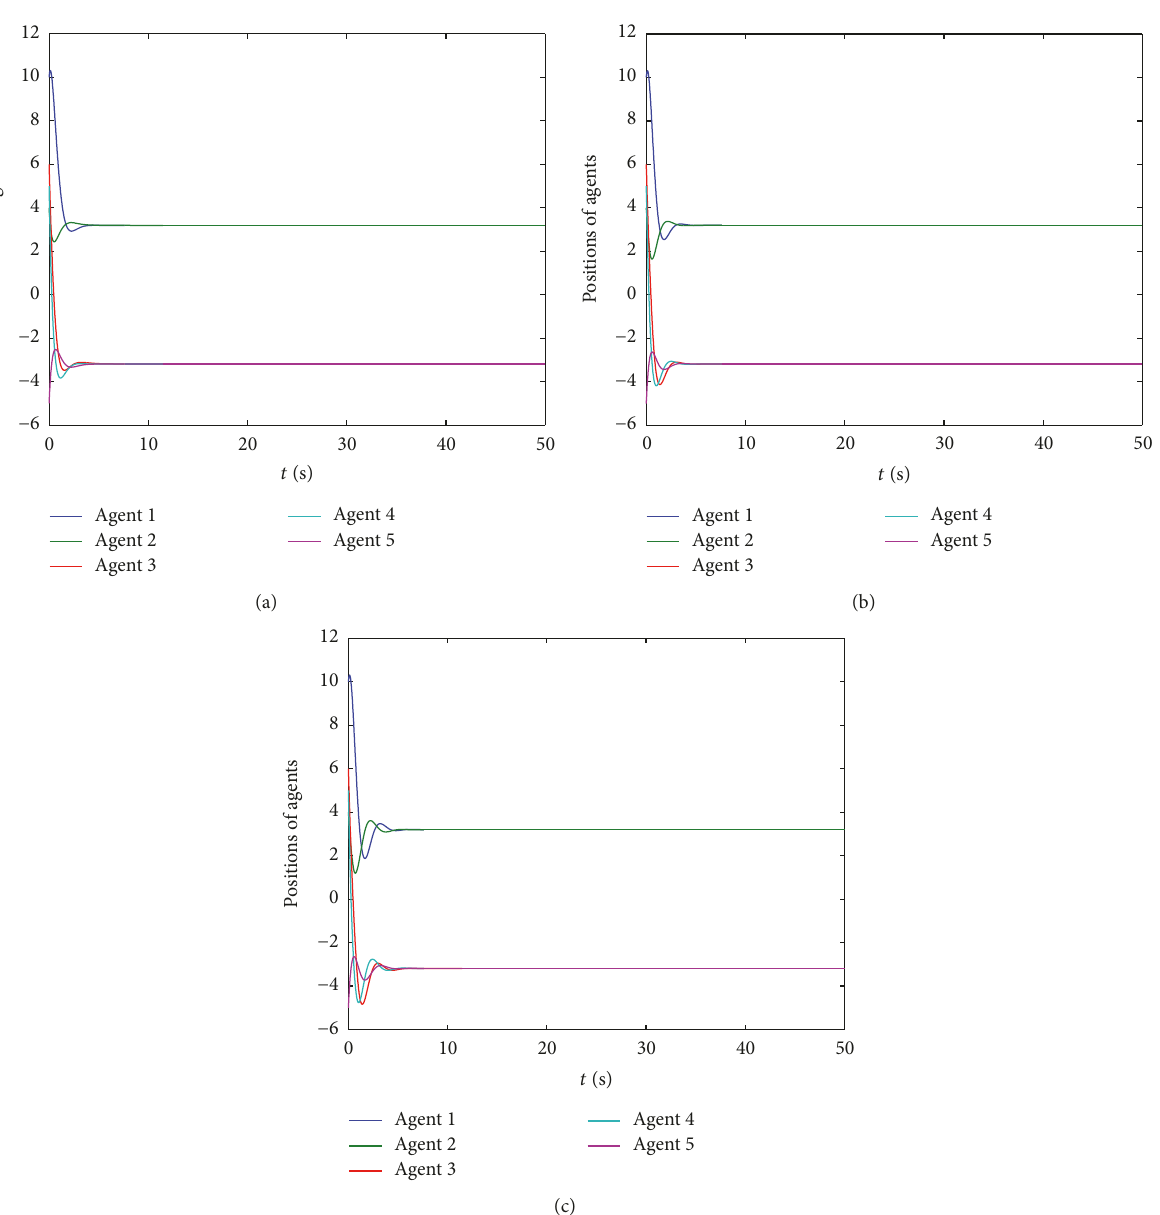
Figure 2: The state trajectories of the agents in systems (3). (a) 𝜏 𝑖𝑗 = 0 s, (b) 𝜏 𝑖𝑗 = 0.3 s, and (c) 𝜏 𝑖𝑗 = 0.5